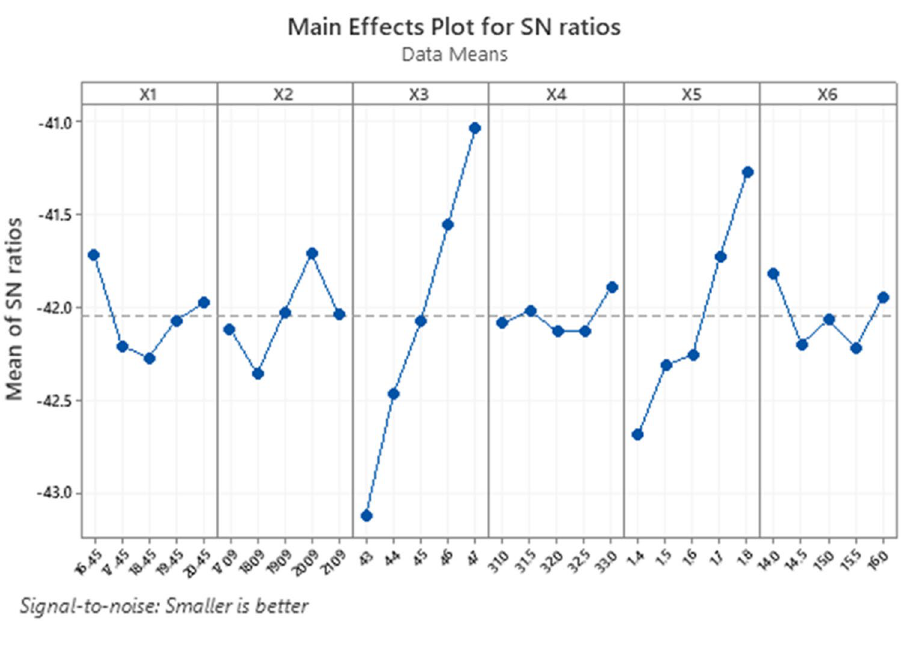
Table 7 Response table for signal to noise ratios (St), smaller is